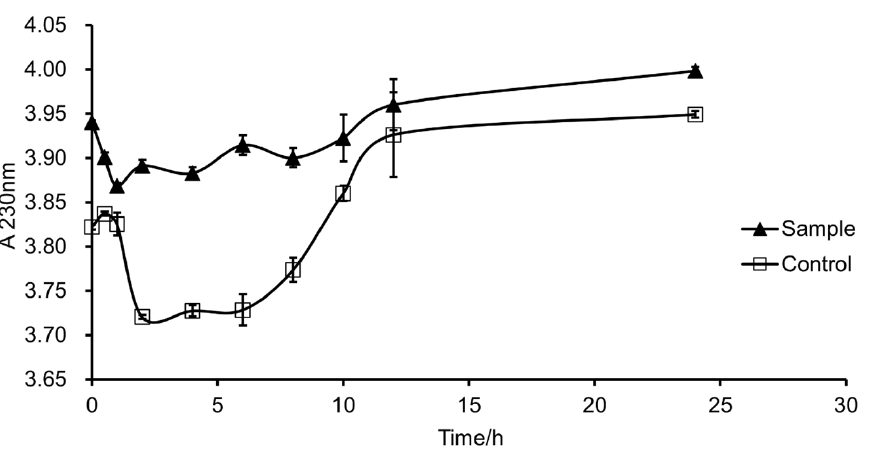
Figure 6. Degradation e ffi ciency of fucoidanase at 232 nm.